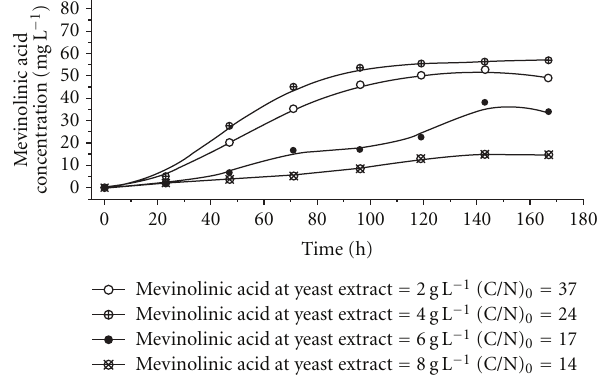
Figure 4: The evolution of mevinolinic acid (lovastatin) production in the batch culture at di ff erent initial yeast extract concentrations and C:N ratio content